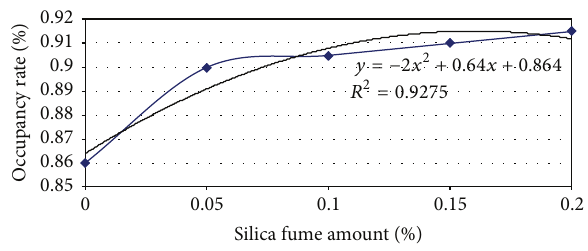
Figure 7: The relation between silica fume additive and compressive strength in concrete with 35/65 fine/large aggregate ratios.